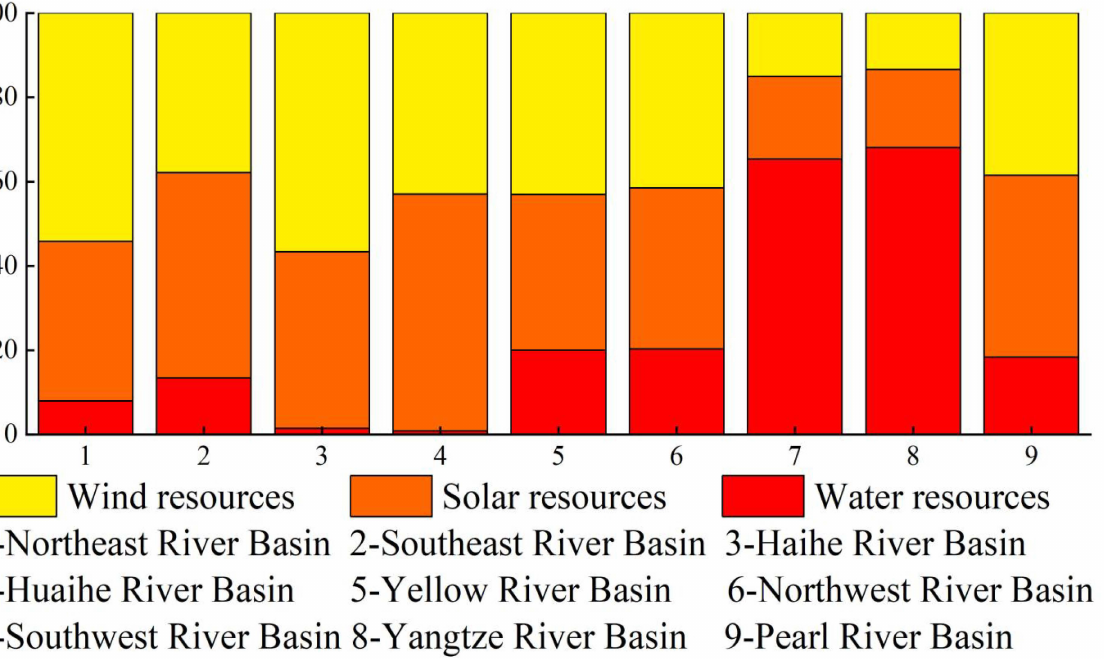
Figure 10. Percent of wind-, hydro-, and solar-energy resources in the nine river basins of